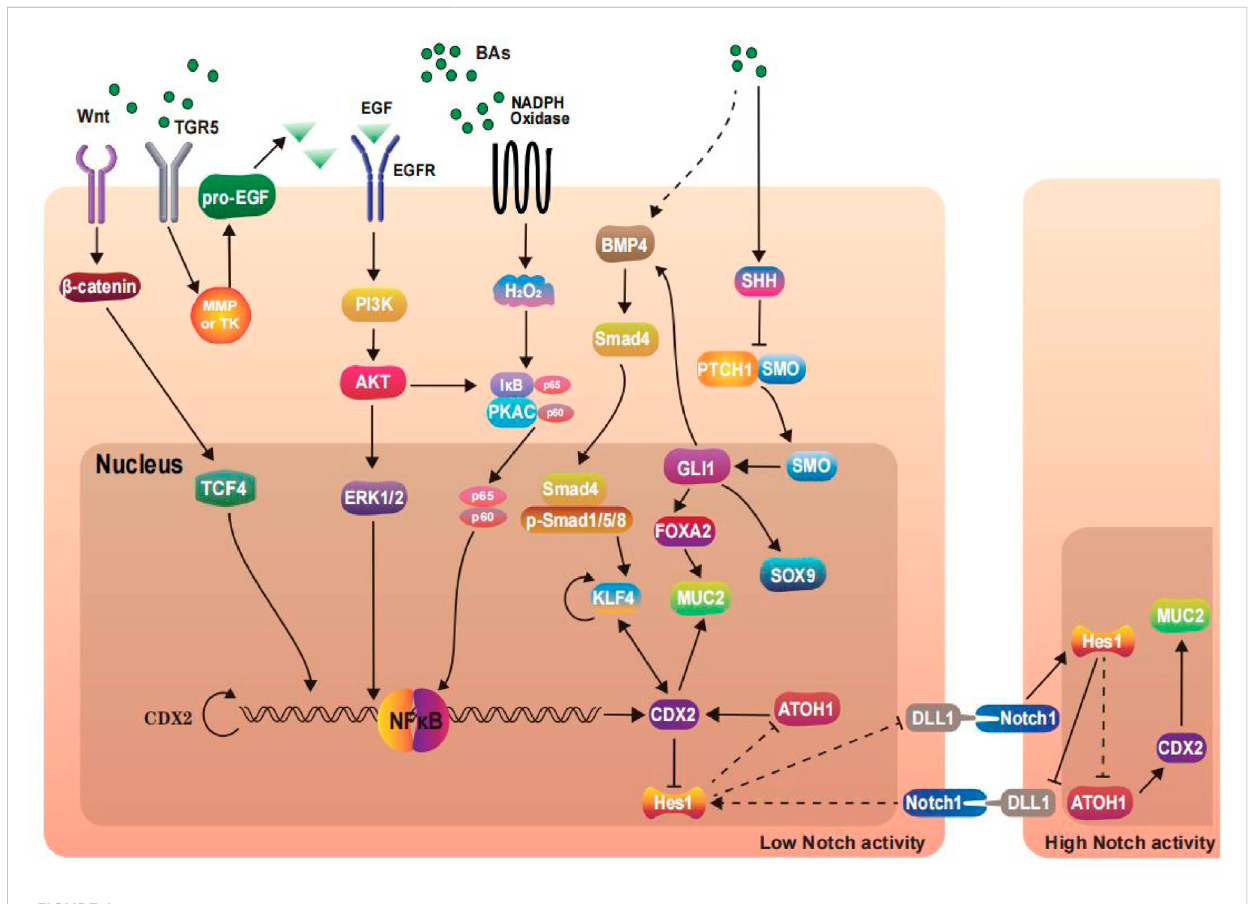
FIGURE 1 Signaling pathways and transcription factors in the development of Barrett ’ s